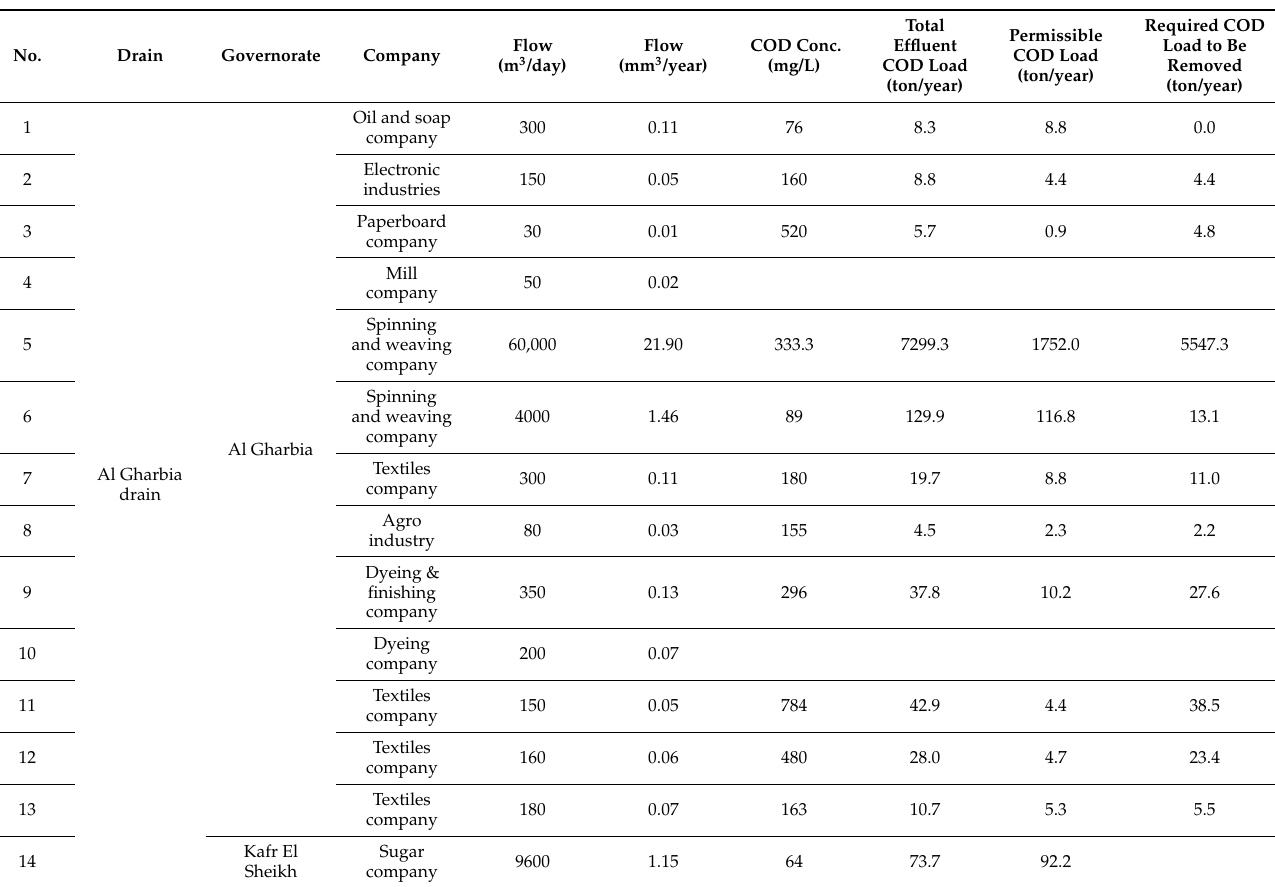
Table 3. Flows and pollution loads from the 16 industrial establishments discharging to Lake